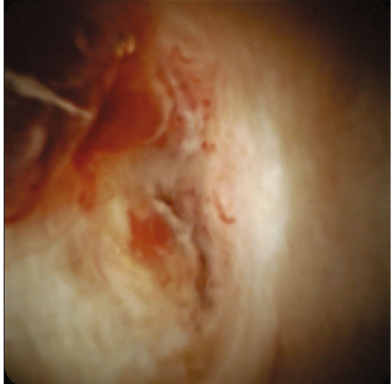
Figure 6: Cholangioscopy (SpyGlass) view of the periductal-type